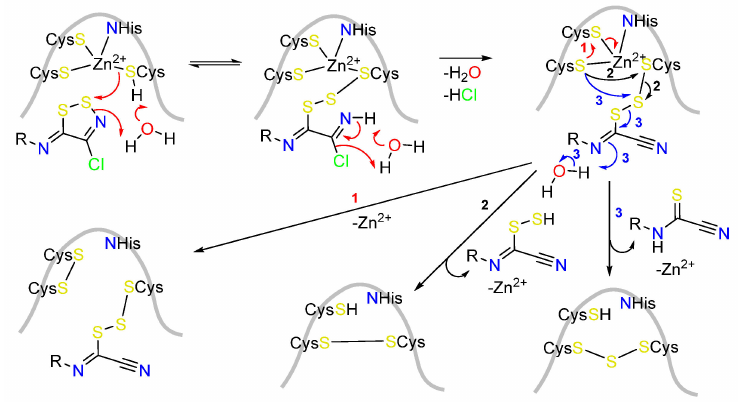
Figure 28. Proposed mechanism of action of the 4-choro-1,2,3-dithiazole